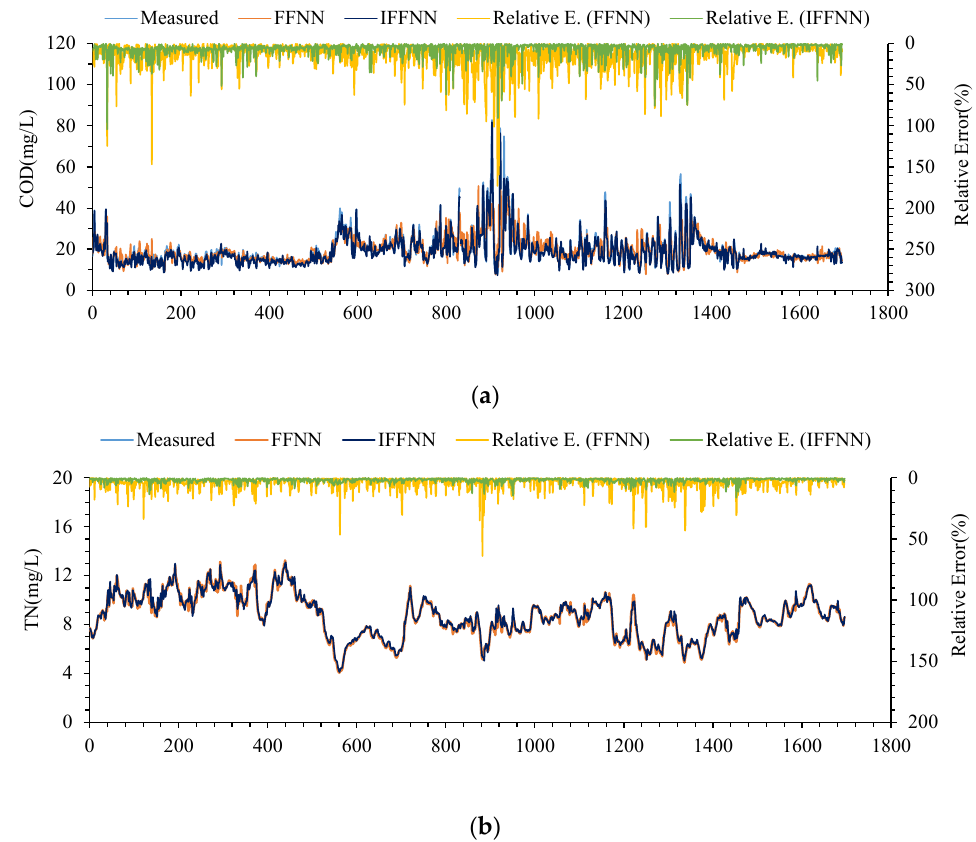
Figure 4. Comparison of real-time WWTP effluent prediction between the FFNN and IFFNN models for the water quality parameters ( a ) COD and ( b ) TN, respectively.